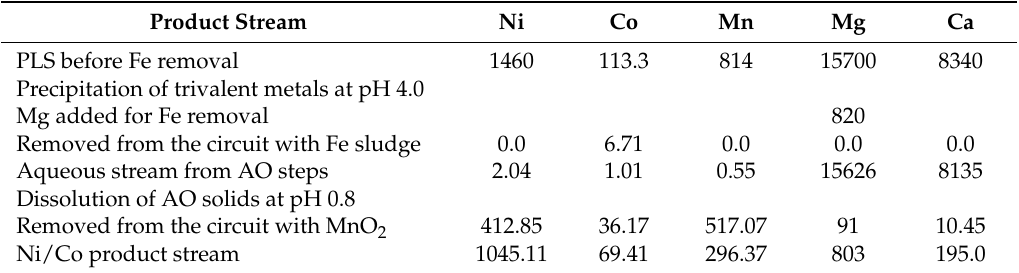
Table 7. Metal distribution (in mg) among streams remaining in the circuit, Fe sludge, MnO 2 precipitates, and final Ni/Co product stream. AO—alkaline oxidation.